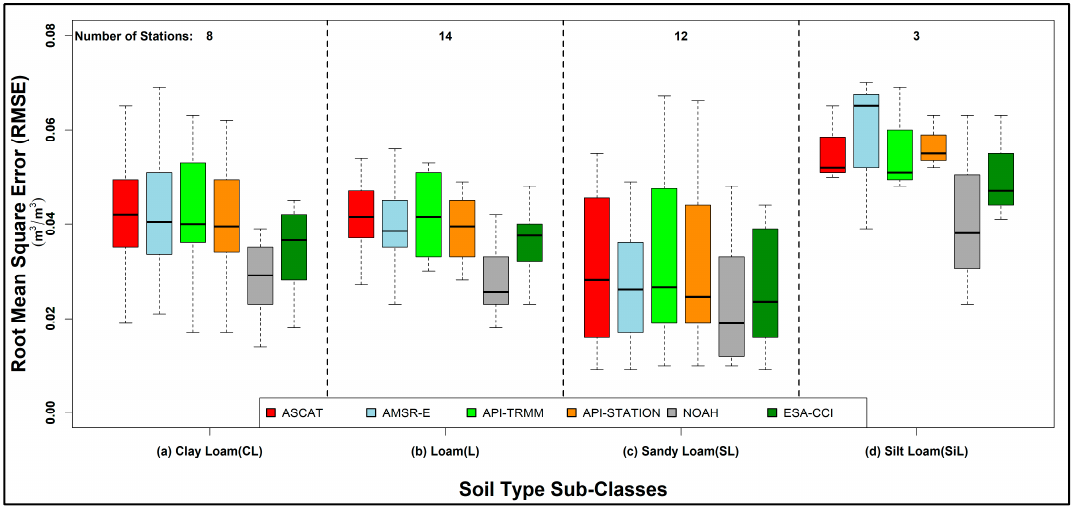
Figure 13. RMSE of soil moisture products under soil type sub-classes.